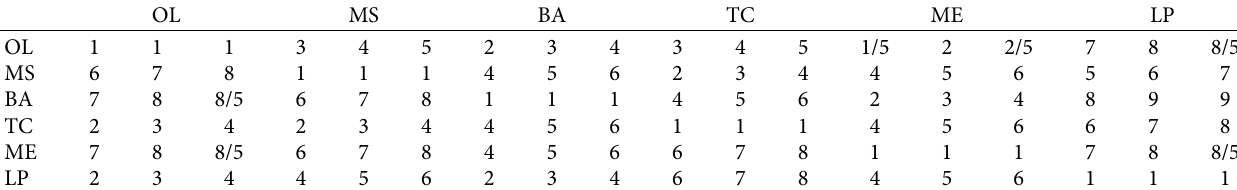
Table 3: Comparison matrix of activities (geometric mean of expert opinions). OL